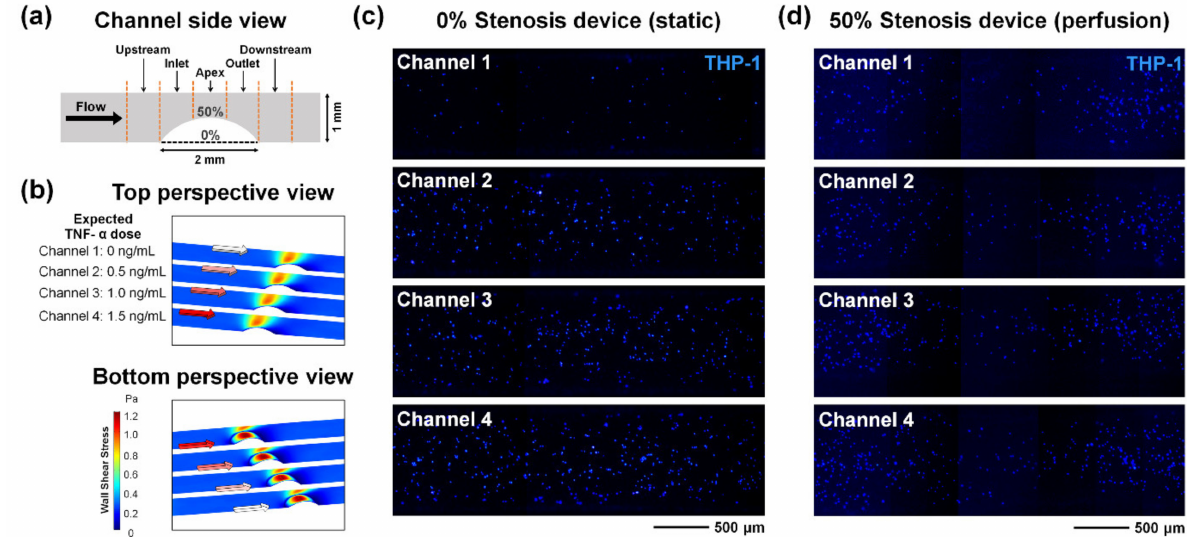
Figure 7. Monocytic THP-1 cell adhesion in the inflammation model. ( a ) The side view of the channel, which was divided into five regions for analysis (upstream, inlet, apex, outlet, and downstream). The presence of a flow and the presence of a stenosis structure were the parameters. ( b ) Simulated wall shear stress of a multichannel stenosis device with 50% occlusion. ( c ) The recruitment of THP-1 cells in each channel of a nonstenotic multichannel device under static culture conditions. ( d ) The recruitment of THP-1 cells in each channel of a multichannel stenosis device with 50% occlusion under perfusion culture conditions. The estimated TNF- α doses were 0, 0.5, 1, and 1.5 ng/mL from channel 1 to channel